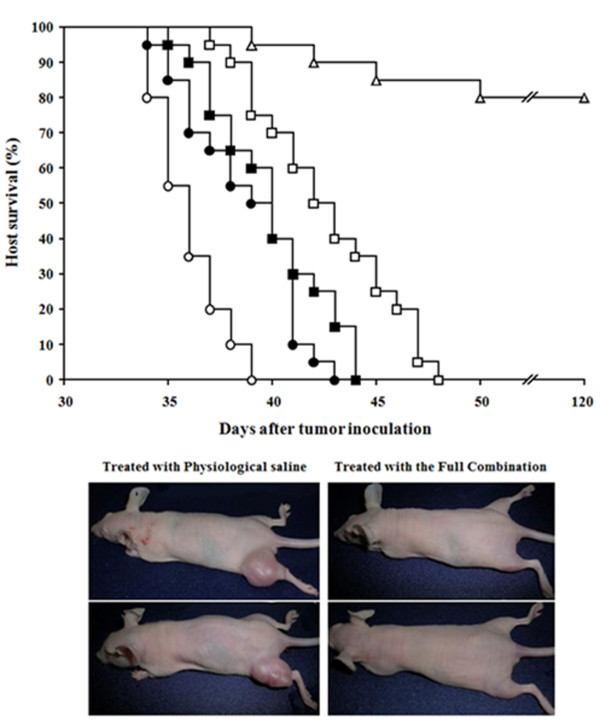
Effect of treatment-induced regression of A375 melanoma xenografts on host survival. A375 melanoma-bearing mice were treated as in Table 1. Host survival was studied in the following treatment conditions: (○) physiologic saline; (●) G3139 + VRP + ACV; (□) G3139 + VRP + ACV + PAC.PBP + DNR; (■) G3139 + VRP + ACV + X-rays; (Δ) G3139 + VRP + ACV + PAC.PBP + DNR + X rays. Representative photos here below correspond to two control mice treated with physiological saline and two mice treated with the full combination therapy that had > 120-day survival. Data are means + S.D. for 20 different mice in each experimental condition.